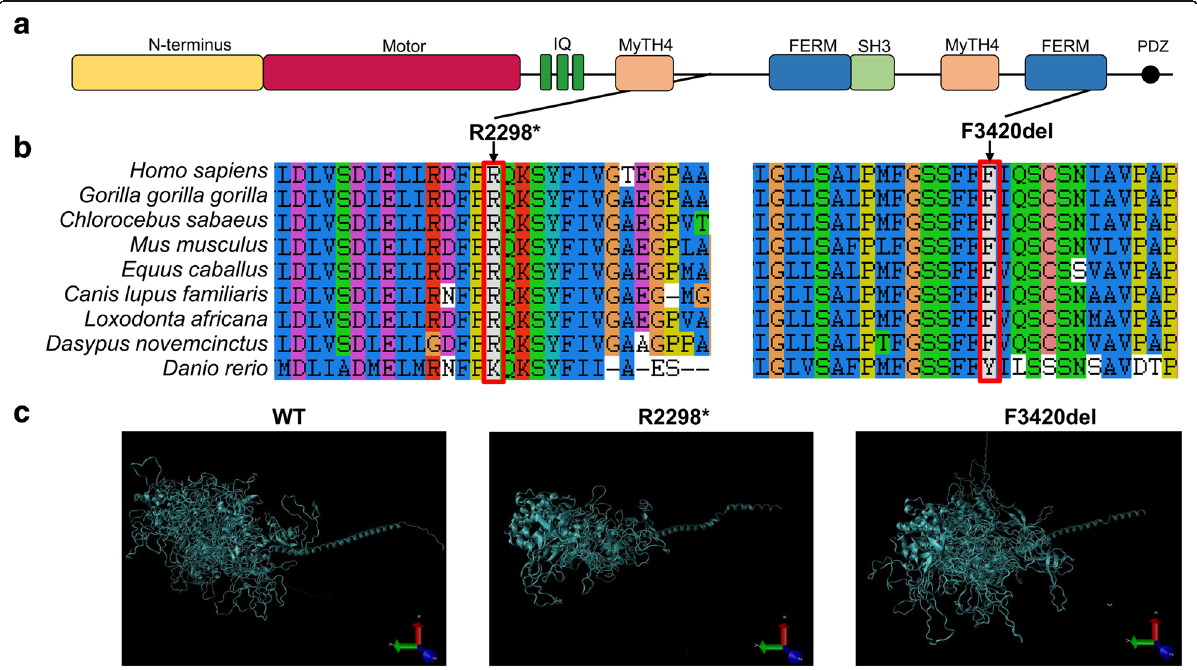
Fig. 2 Functional analysis of the MYO15A mutant protein. a Schematic representation of MYO15A protein domain structure. A motor domain, three IQ motifs, two MyTH4 domains, two FERM domains, a SH3 domain, and a PDZ domain are depicted. b Multiple sequence alignment showed that R2298 and p.F3420del are positioned in a highly conserved region. Changes in amino acids are highlighted in the red boxes. c Molecular modeling revealed that the p.R2298* and p.F3420del mutants affect the normal protein structure of